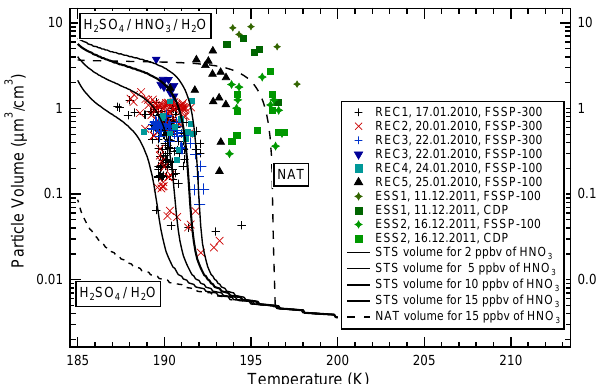
Figure 9. Measured particle volumes vs. temperature and theoret- ical calculations as discussed in Peter (1997). The STS-mode size range was partly resolved by the FSSP-300. The measured data points are designated as crosses, which also indicate that only par- ticle diameters below 2µm were integrated for calculation of the particle volume. The theoretical curve for STS volume was calcu- lated according to Carslaw et al. (1995) with the FSSP-300 lower cut-off at 0.46µm. Four curves for different mixing ratios of HNO 3 of 2, 5, 10 and 15ppbv are plotted. Solid symbols contain only vol- umes including particle diameters above 2µm. The dashed lines in- dicate particle volumes for the binary solution and for NAT assum- ing 15ppbv of HNO 3